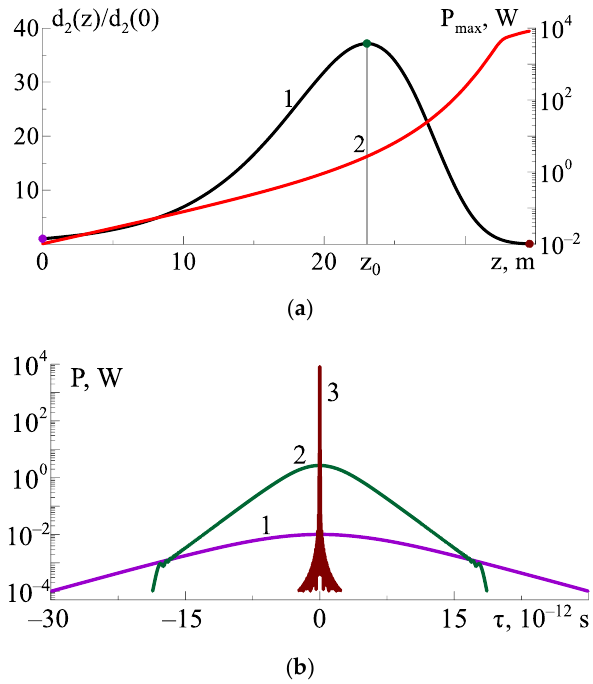
Figure 1. Evolution of the secant–hyperbolic FM-pulse envelope in the fiber segment: ( a ) dispersion profile (curve 1, left axis), pulse peak power (curve 2, right axis); ( b ) pulse envelope at the fiber segment input (curve 1), at the point z = z 0 (curve 2), and at the fiber segment output (curve 3). The violet, dark-green, and brown points on curve 1 in ( a ) correspond to the curves of the same-colors at ( b ). The parameters of fiber and input signal are listed in Table 1.